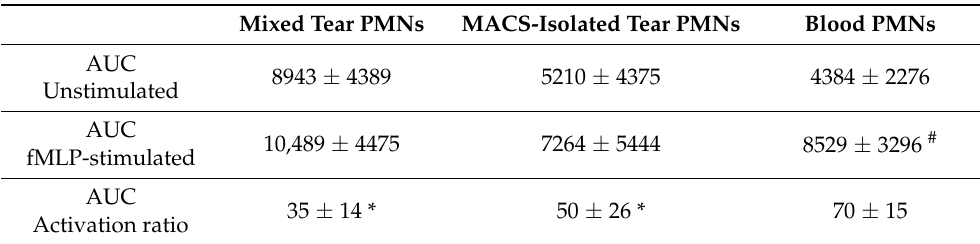
AUC (area under the curve) were computed using GraphPad Prism Software. n = 16 from 15 participants for mixed tear PMNs, and n = 11 from 9 participants for MACS-isolated tear PMNs, and n = 5 from 4 participants for blood PMNs, values are represented as means ± standard deviations. * Significantly different from blood PMNs ( p ≤ 0.01). # Significantly different from unstimulated PMNs ( p ≤ 0.005, paired t